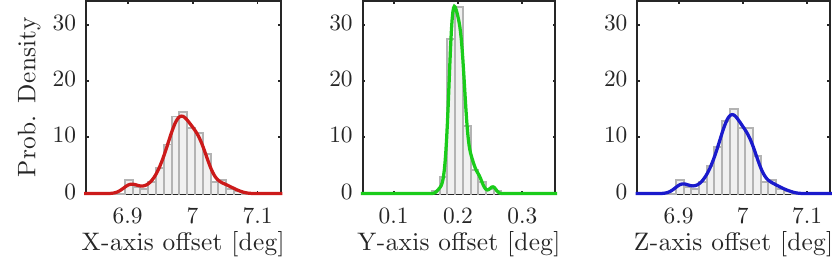
Figure 11. Calculated angular offset (measured between the ideal principal axes and measured principal axes) for 200 measurements of the pole-shoe TCP using the inductive proximity sensor (Sensor B).